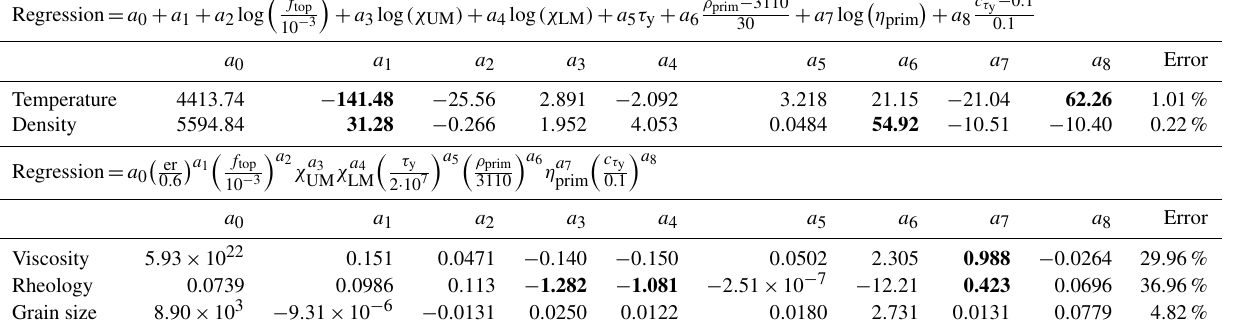
Table 4. First-order regressions of pile spatial and temporal averages. Temperature and density are fitted with an additive form as their variations are small. Viscosity, rheology and grain size are fitted with a power-law equation. Important input parameters are printed in